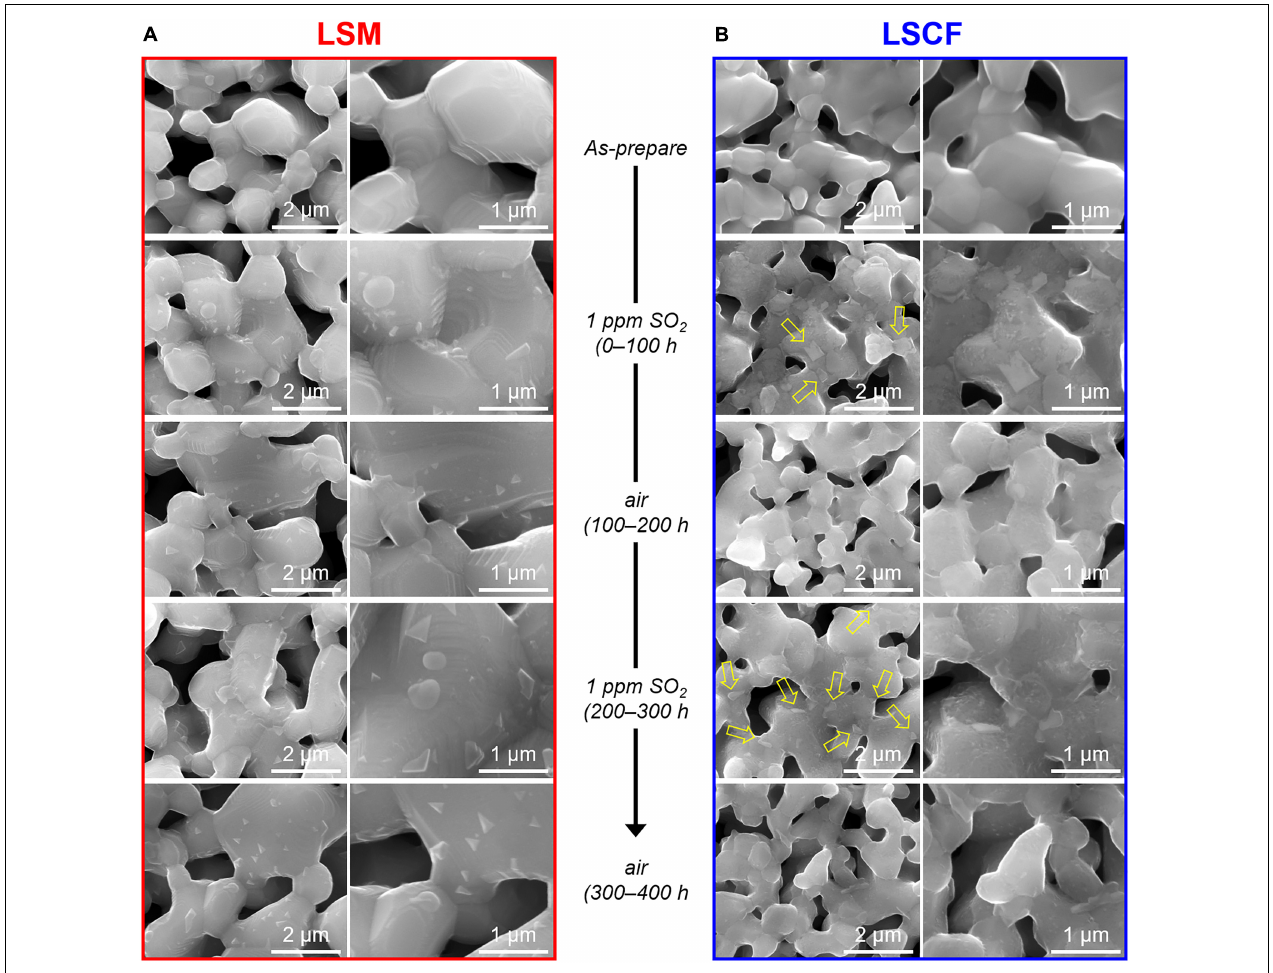
FIGURE 6 | SEM images of (A) LSM and (B) LSCF particles exposed to an alternating atmosphere of air and 1 ppm SO 2 (air balance) for 400 h at 700 ◦